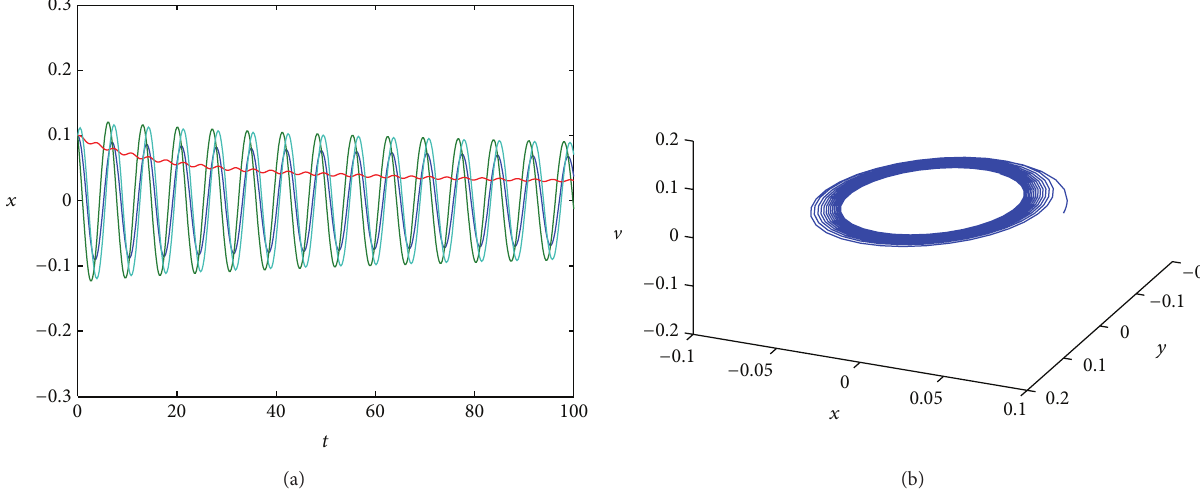
Figure 6: Time history and phase diagram of system (16) with 𝑎 = 1 , 𝑐 = 0.08 , 𝑚 = 0.5 , 𝑘 1 = 0.8 , 𝑘 2 = 0.5 , and 𝑏 = −0.175 .